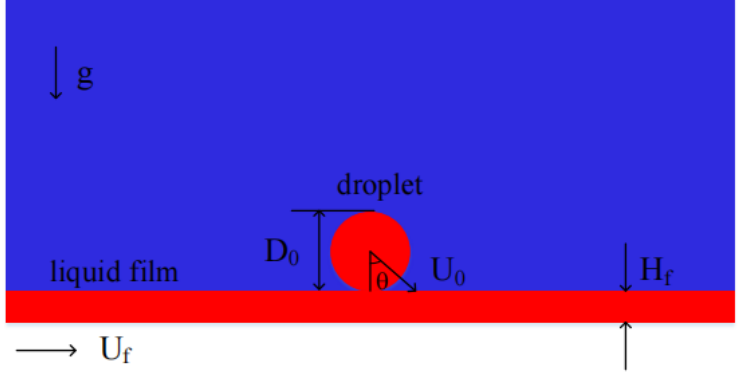
Figure 1. Schematic diagram of single droplet impacting a dynamic liquid film at a certain